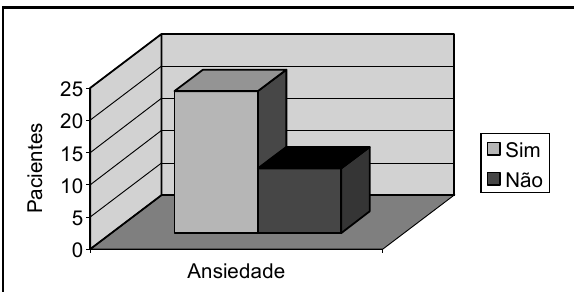
Figura 5 – Distribuição dos pacientes relacionada com a ansiedade